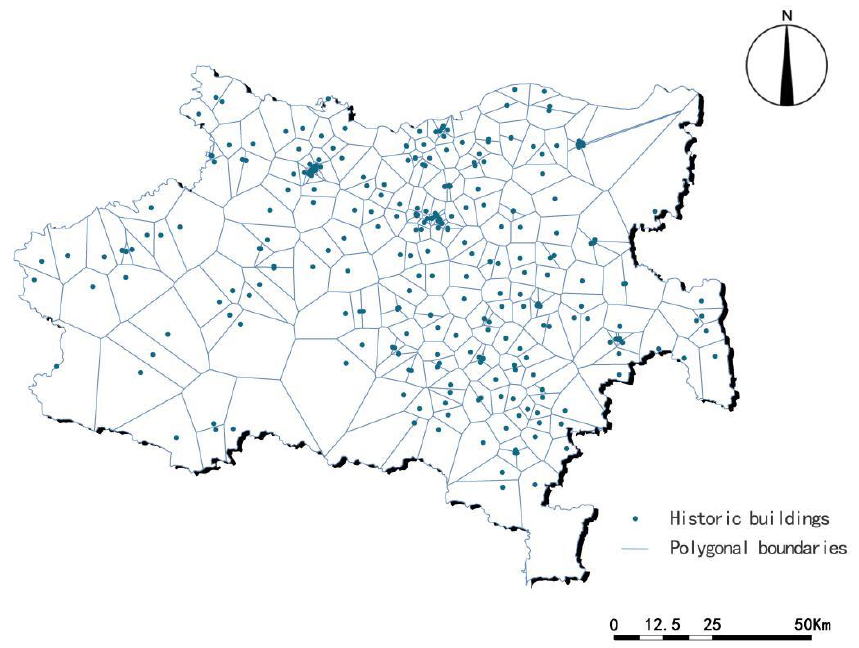
Figure 6. The Voronoi diagram of the distribution of historical buildings in the Songshan region.